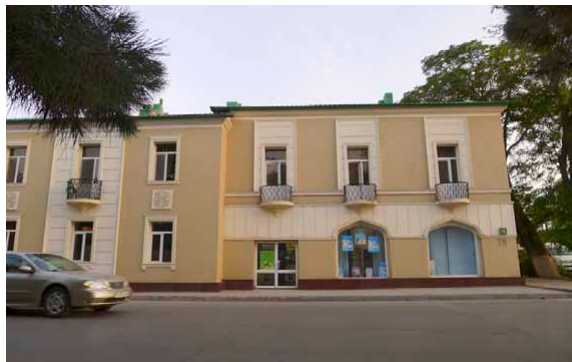
fig. 18. residential houses of ashgabat, Turkmenistan. r. Čepai- tienė